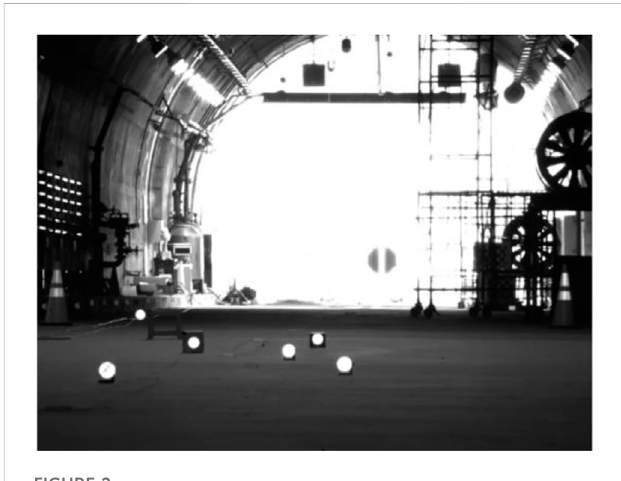
FIGURE 2 Imaging effect of circular re fl ective mark.